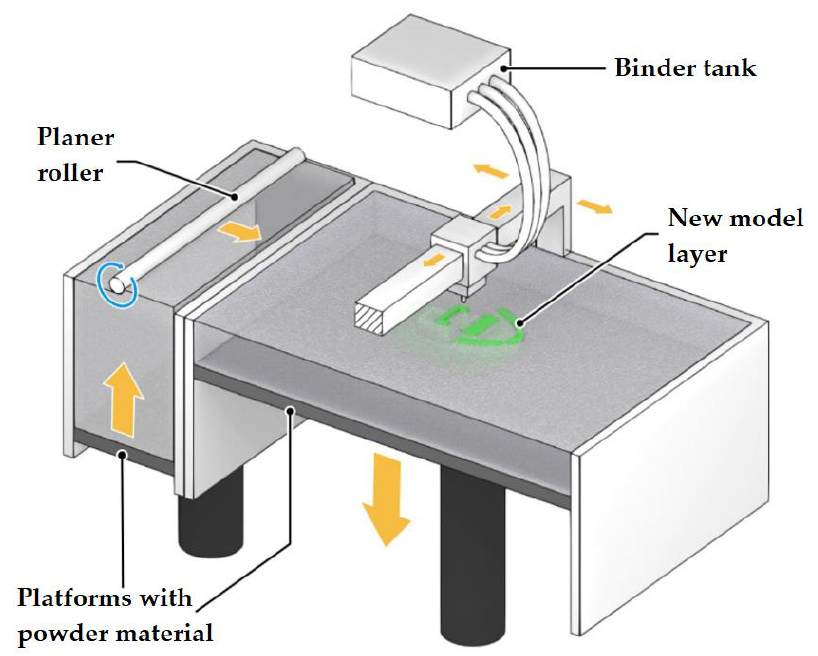
Figure 6. Binder Jetting (Powder Bed Printing), a schematic